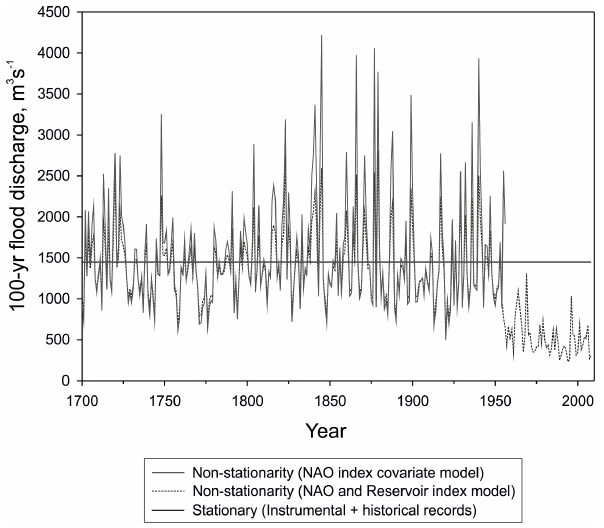
Figure 11. Quantile estimates of the annual maximum floods with 0.01 annual exceedance probability based on stationary and non- stationary